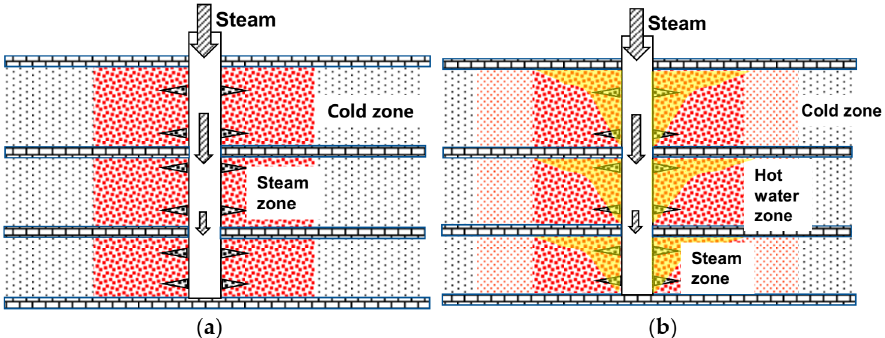
Figure 1. A schematic diagram of a multilayer heavy oil reservoir; ( a ) conventional mode; ( b ) our